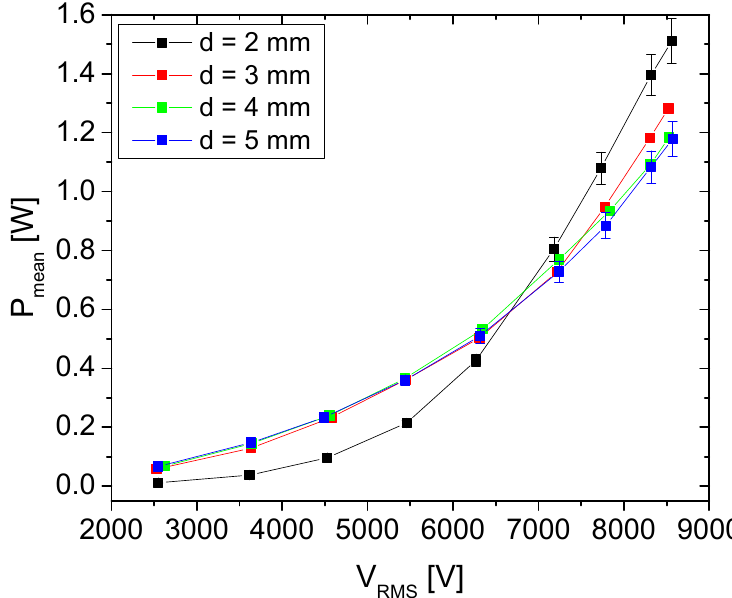
Figure 9. Mean power transmitted to the discharge as a function of the voltage at the powered elec- trode.